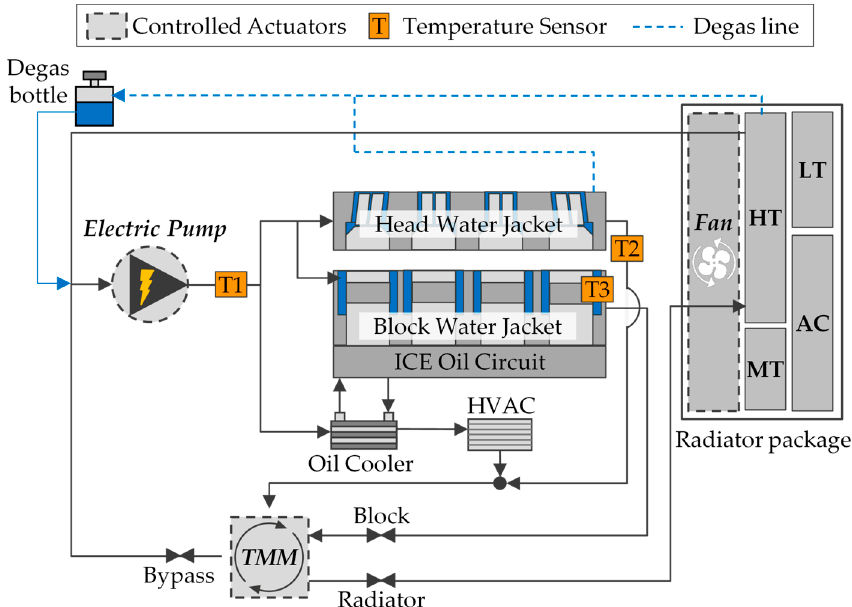
Figure 3. Schematic layout of high-temperature cooling circuit including controlled actuators and temperature sensors (TMM: Thermal Management Module, HT: High-temperature circuit, MT: Medium-temperature radiator, LT: Low-temperature radiator, AC: Air condenser, HVAC: Heating, Ventilation, Air Conditioning heat exchanger).